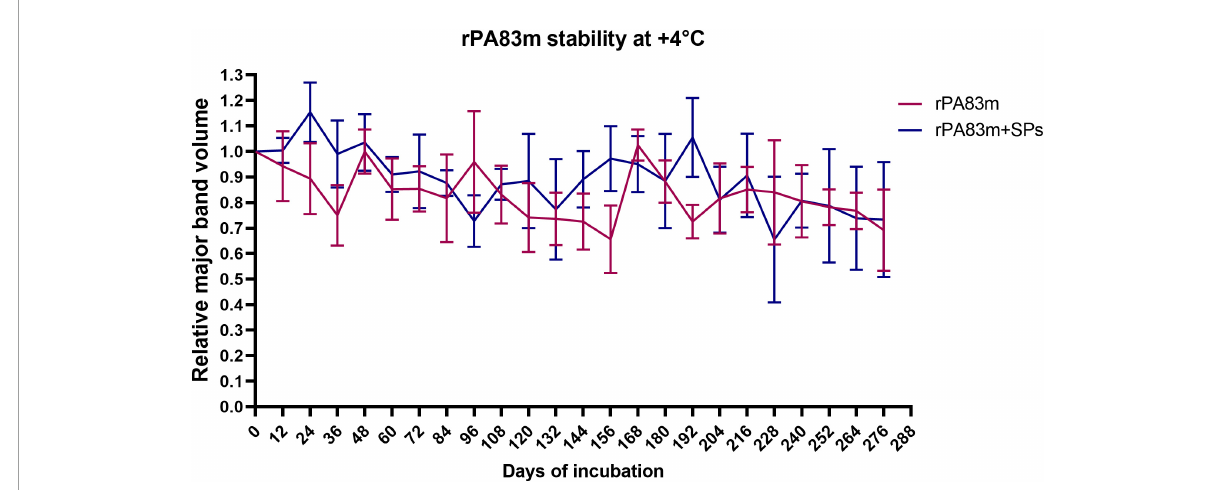
FIGURE3 Stability of individually formulated rPA83m and rPA83m as a part of rPA83m + SPs compositions at +4 ◦ C. Individually formulated rPA83m and rPA83m + SPs compositions were incubated at +25 ◦ C. In both cases rPA83m concentration was 1 µ g/ µ l. rPA83m/SPs mass ratio was 1:10. For each checkpoint, relative major band volume means are presented for both individually formulated rPA83m (red) and rPA83m as a part of rPA83m + SPs compositions (blue) (the number of replicates was n = 5, except for rPA83m day 72 and rPA83m + SPs day 264, in which case it was n = 4 and 3, respectively). Stability evaluation for all incubated replicates was carried out by 8–20% SDS-PAGE analysis. For each replicate, the mean value of major band volumes determined by comparison with two corresponding non-incubated samples (except for rPA83m + SPs at day 228, in which case only 1 standard sample was used) was used for graph plotting and group comparison. Bars represent 95%